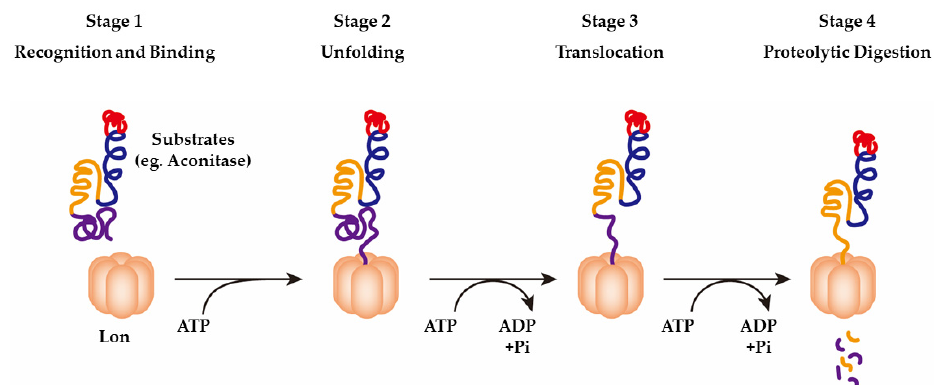
Figure 3. Illustration of the procedure for ATP-dependent proteolysis of substrates by LonP1, cited and modified from Venkatesh S, Biochim Biophys Acta. 2012 [35].